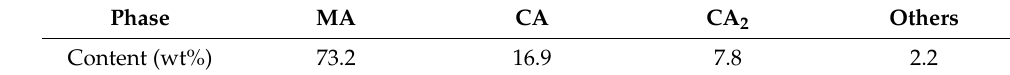
Table 2. Mineralogy of CMA aggregates.